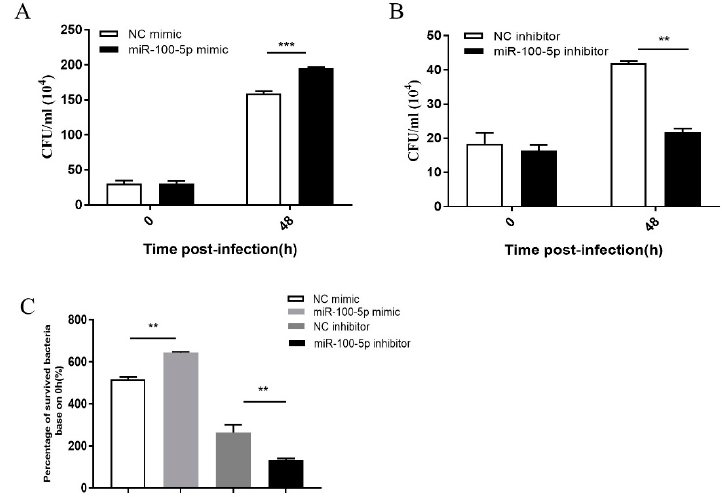
Figure 5. miR-100-5p promotes BCG survival in macrophages. THP-1 cells were transfected with NC mimic, miR-100-5p mimic, NC inhibitor, or miR-100-5p inhibitor for 24 h and infected with BCG at MOI 10 for 8 h. ( A , B ) Viable intracellular BCG in THP-1 cells transfected with miR-100-5p mimic or inhibitor compared to the negative control. ( C ) Percentage analysis of surviving intracellular bacteria based on 0 hpi with four groups. Data are from three independent experiments with biological duplicates in each (( A – C ); mean ± s.e.m. of n = 3 duplicates). ** p < 0.01; *** p < 0.001.